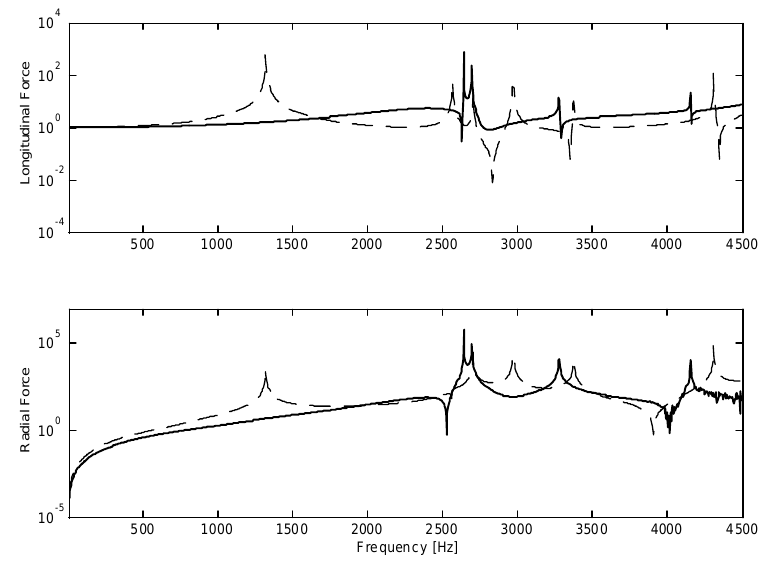
Fig. 17. Transmitted force: type (C) tapered shell (solid), uniform shell